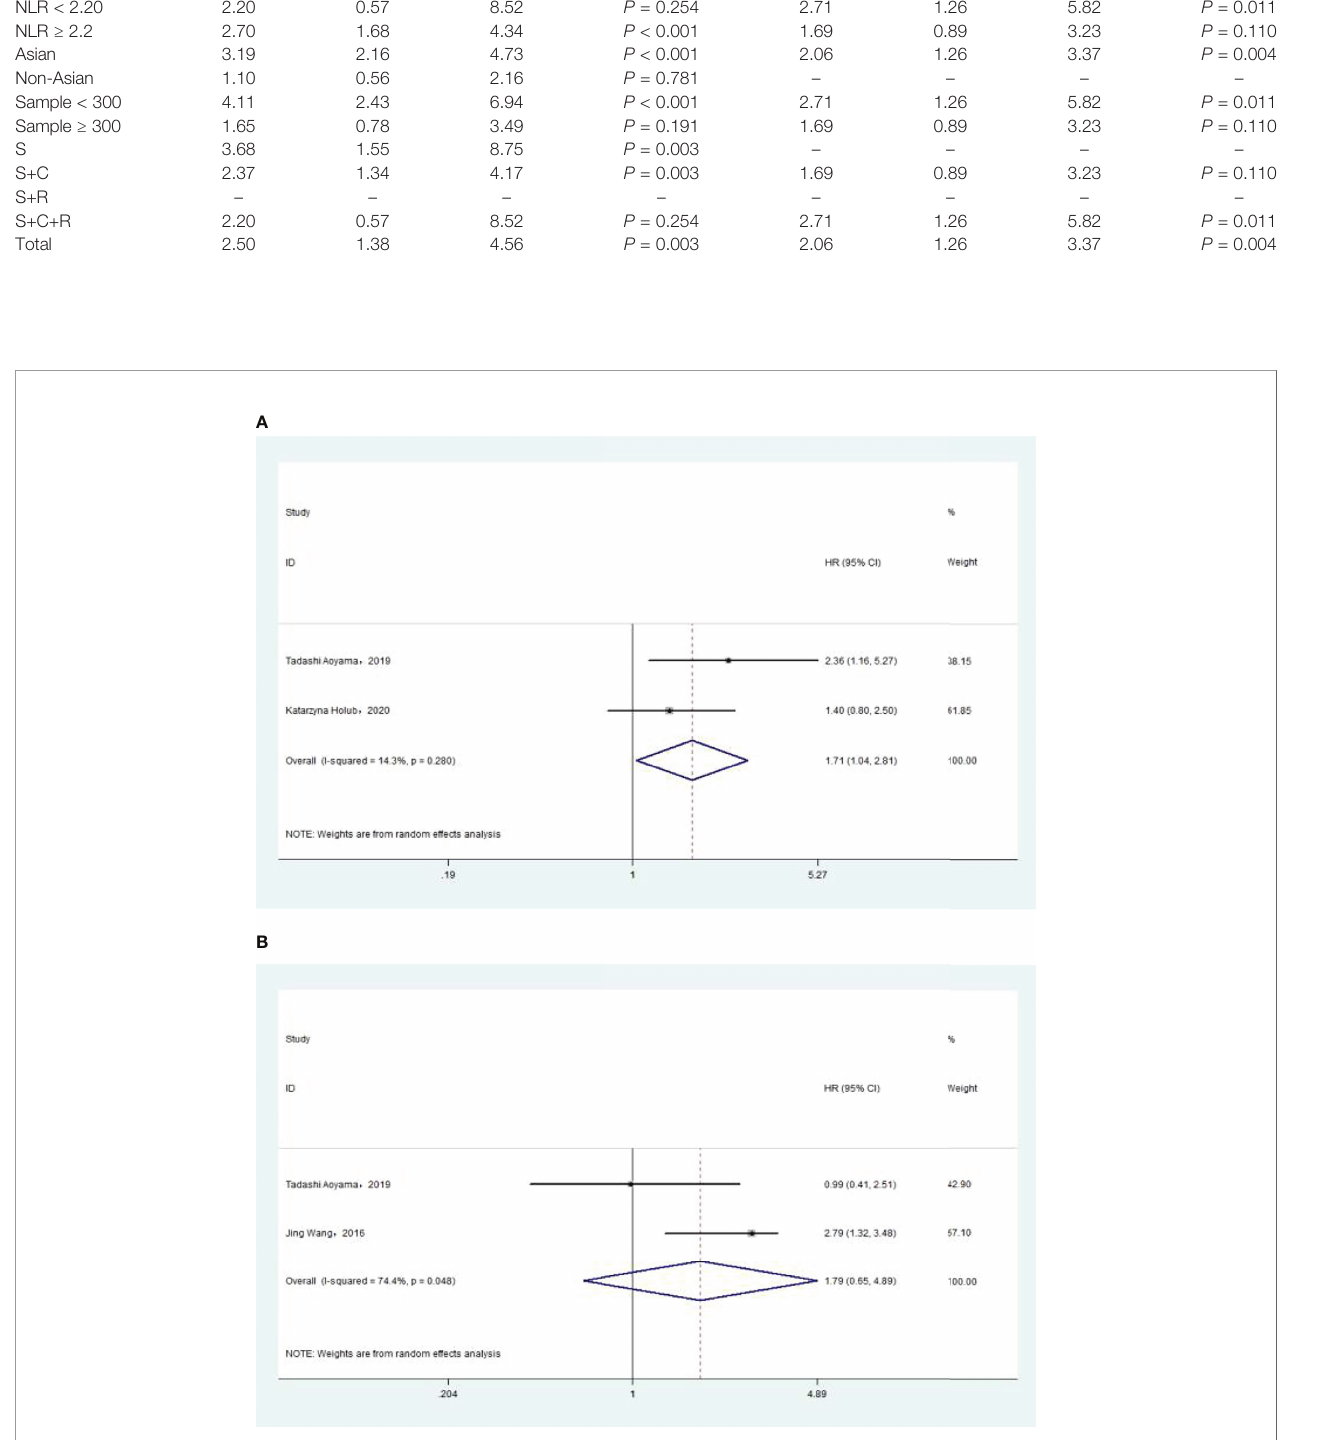
FIGURE 4 | (A) Relationship between neutrophil – lymphocyte ratio (NLR) and progression-free survival (PFS) in univariate analysis. (B) Relationship between NLR and PFS in multivariate analysis.